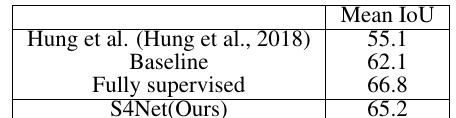
Figure 3. Some examples of land cover classification dataset on DeepGlobe Challenge.